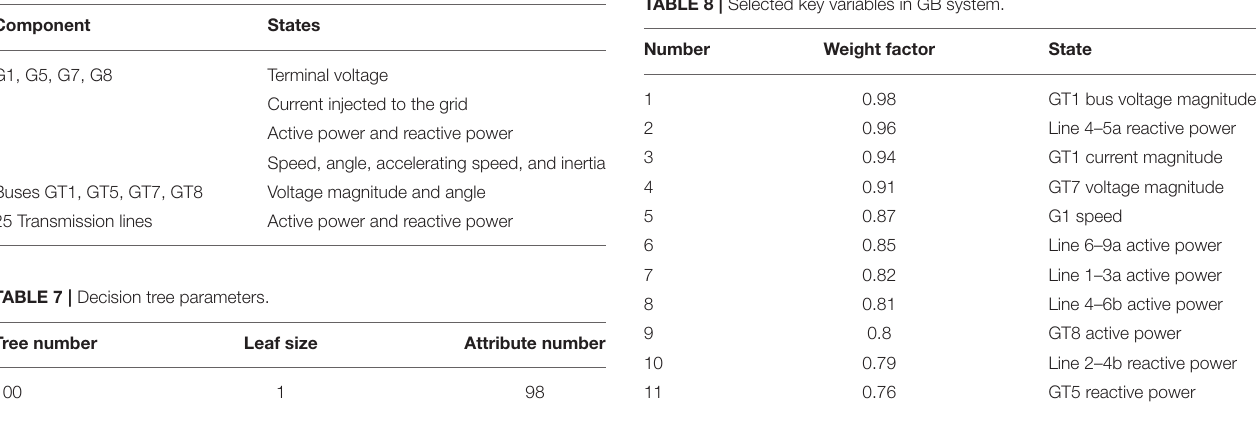
TABLE 6 | Observed variables in the north area.